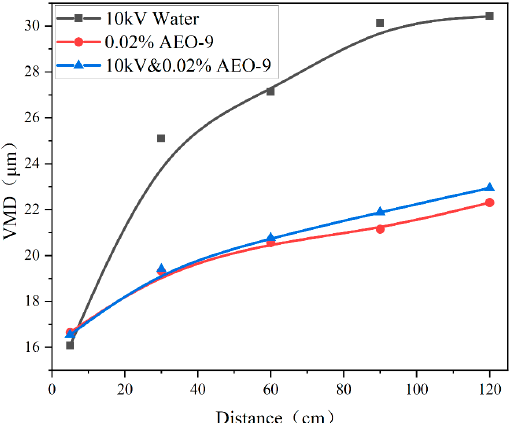
Figure 9. The water mist droplet size of 10 kV water, 0.02% AEO-9, and 10 kV and AEO-9.